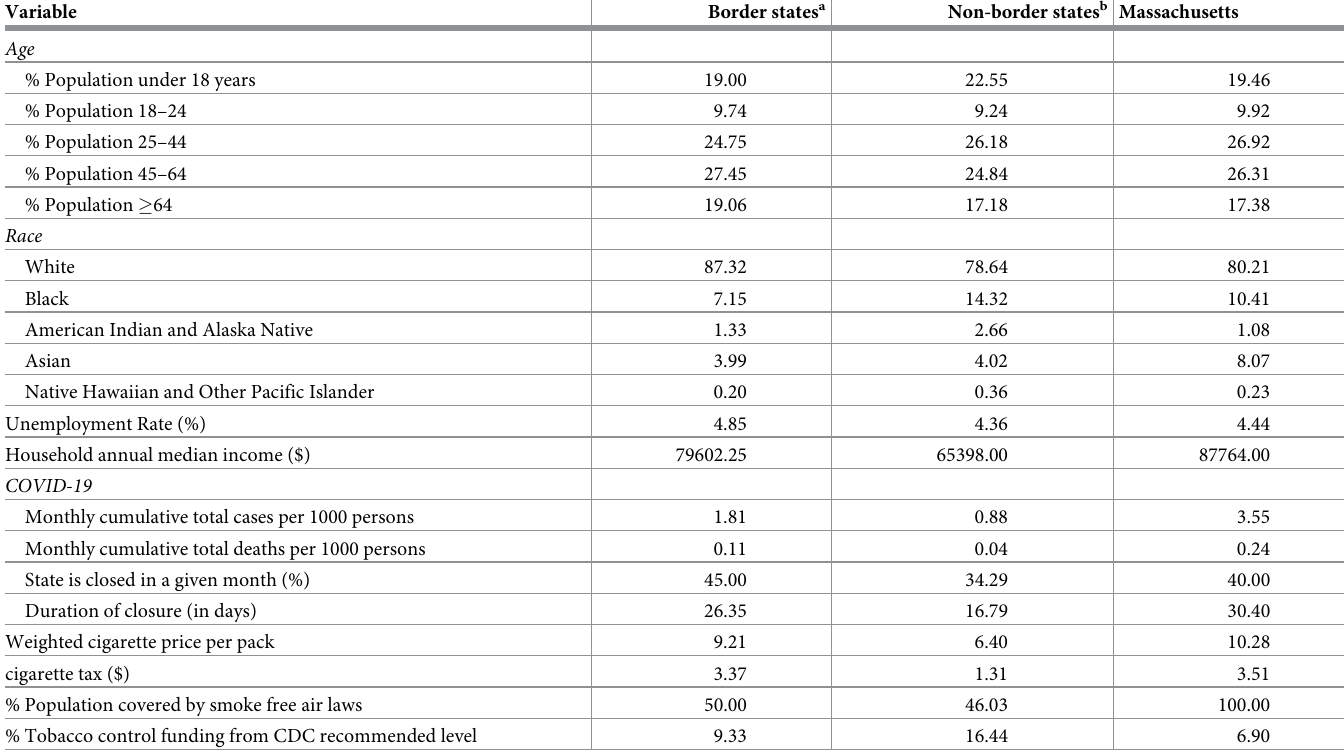
Table 1. Means of state characteristics for border and non-border states during January 2020-May 2020 (before Massachusetts law prohibiting flavored tobacco products sales).